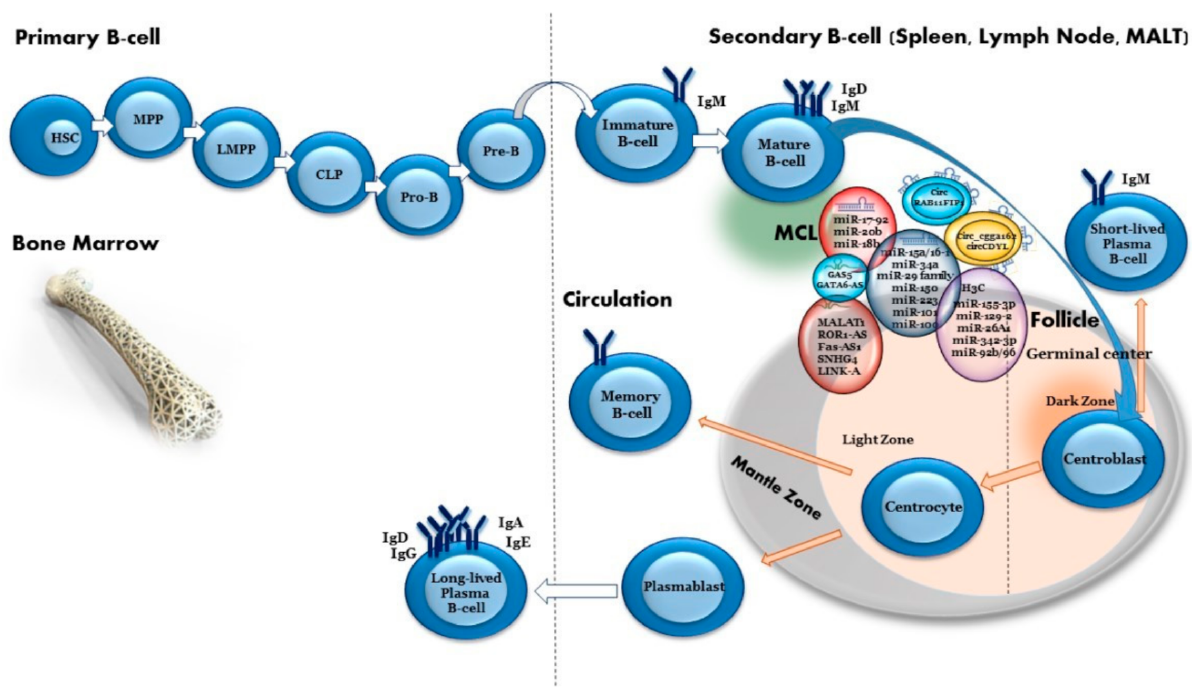
Figure 2. The role of ncRNAs in mantle cell